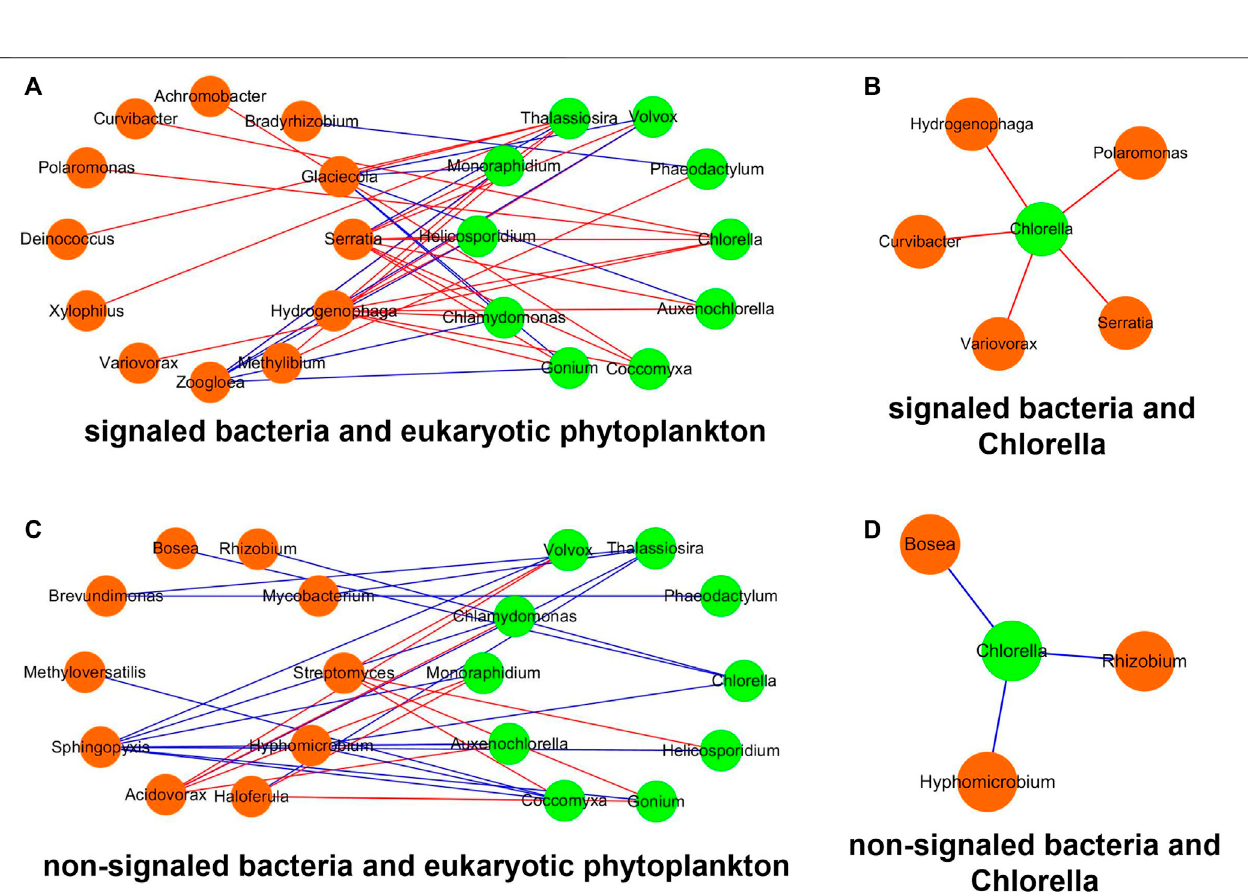
Frontiers in Bioengineering and Biotechnology |